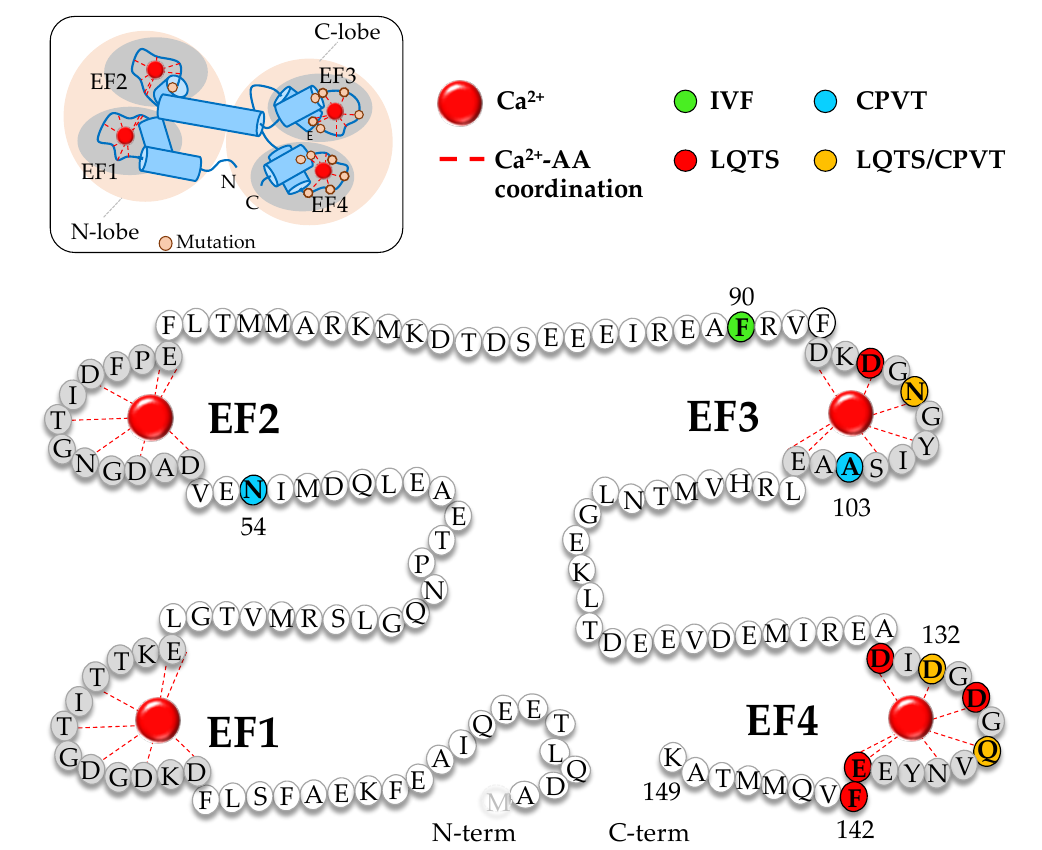
Figure 1. Location of the different mutations in calmodulinopathies. Top left panel: schematic representation of the structure of CaM showing Ca 2+ coordination and mutations found in calmodulinopathies. The grey areas highlight the EF-hands shown in the main panel. Disease-associated residues are colored in green (IVF: idiopathic ventricular fibrillation), blue (CPVT: catecholaminergic polymorphic ventricular tachycardia), red (LQTS: long QT syndrome) and orange (both: LQTS/BrS) in the CaM sequence. The Ca 2+ -binding loop of each EF-hand is emphasized with a grey background.